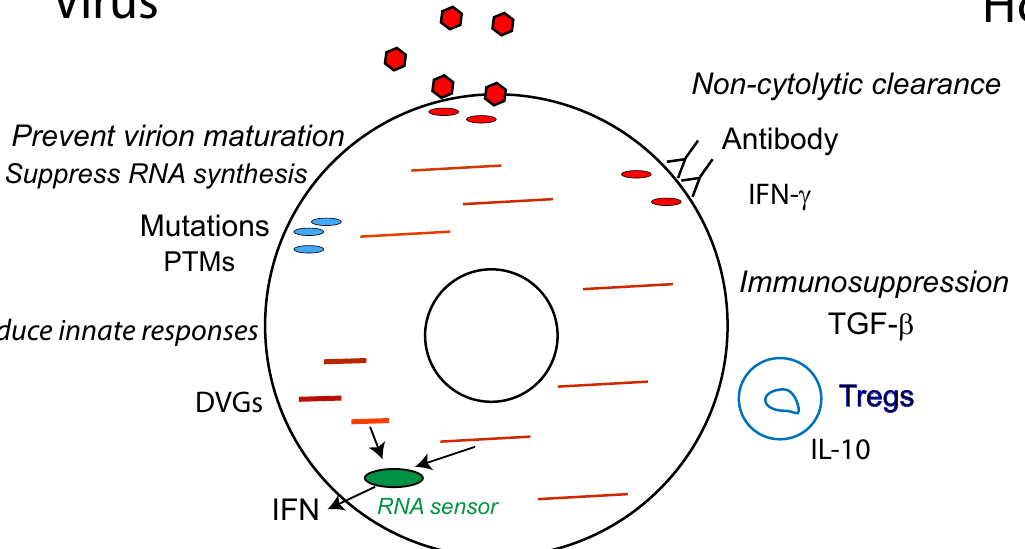
Fig 3. Mechanisms for suppressing production of infectious virions. Several mechanisms exist whereby the virus and host can suppress the production of infectious virions to facilitate the survival of infected cells and viral RNA persistence. For example, the virus may acquire mutations that decrease virion assembly, induce innate responses, or decrease RNA synthesis, while the host employs antiviral immune responses that facilitate infected cell survival. DVG, defective viral genome; IFN, interferon; IL, interleukin; PTM, posttranslational modification; TGF, transforming growth